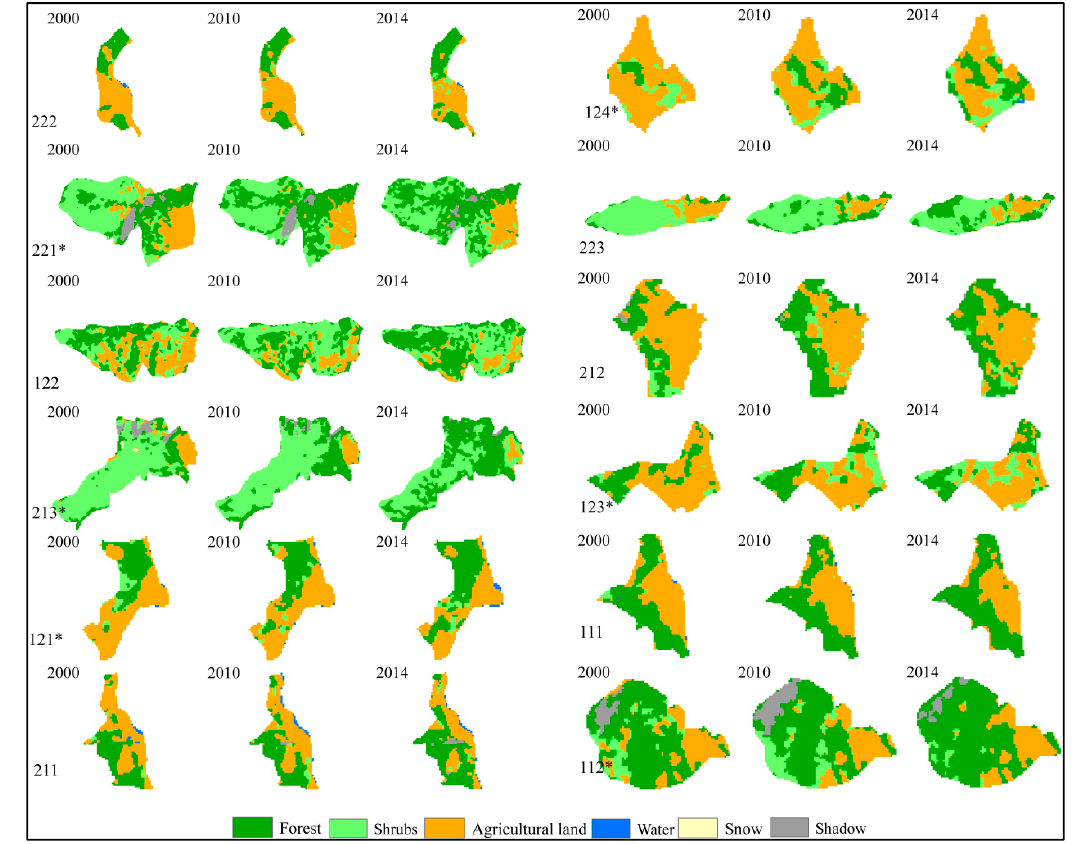
Figure 2. The distribution and composition of land cover for each community during three periods. * indicates communities that implemented RFFP. The map was plotted in ArcGIS v10.2.